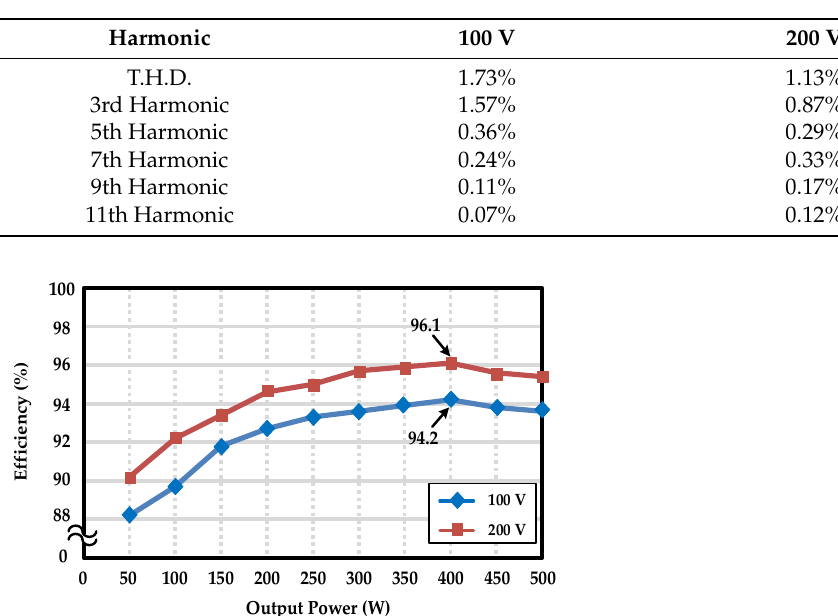
Table 4. The total harmonic distortion and odd-order harmonics of the output voltages.